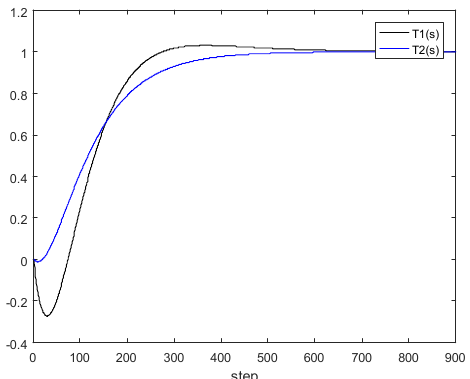
Figure 2. Step response for T 1 and T 2 transfer functions simulated for 900 time-steps.